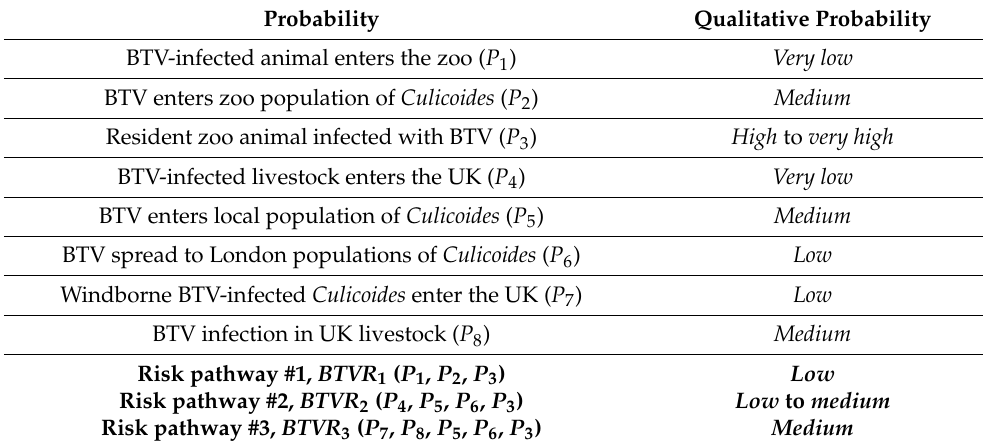
Table 4. Qualitative probability estimates for BTV risk parameters and pathways during the vector active